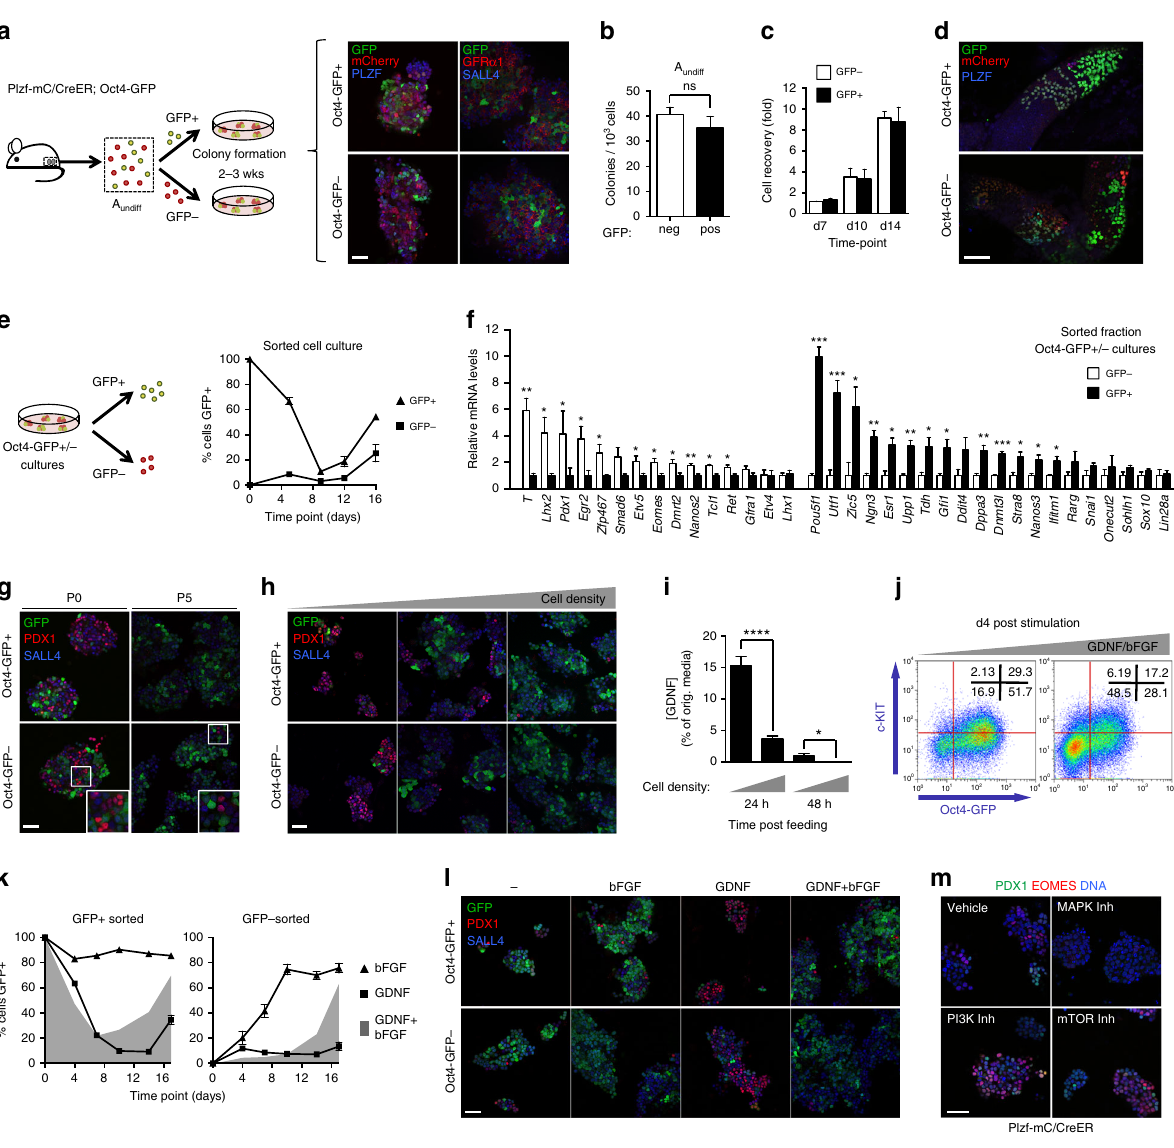
Fig. 6 A undiff heterogeneity during culture. a Oct4-GFP − and GFP + A undiff from Plzf-mC/CreER; Oct4-GFP adults placed in culture and analysed 2 – 3 weeks later. Right: IF of colonies ( n = 2 per fraction). Scale bar, 50 μ m. b Mean colony-forming ef fi ciency of Oct4-GFP − and GFP + A undiff ± s.e.m. from a ( n =